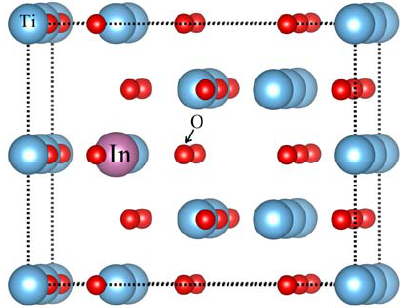
Figure 1. Insertion of Indium atom at Ti site in anatase TiO 2 network.